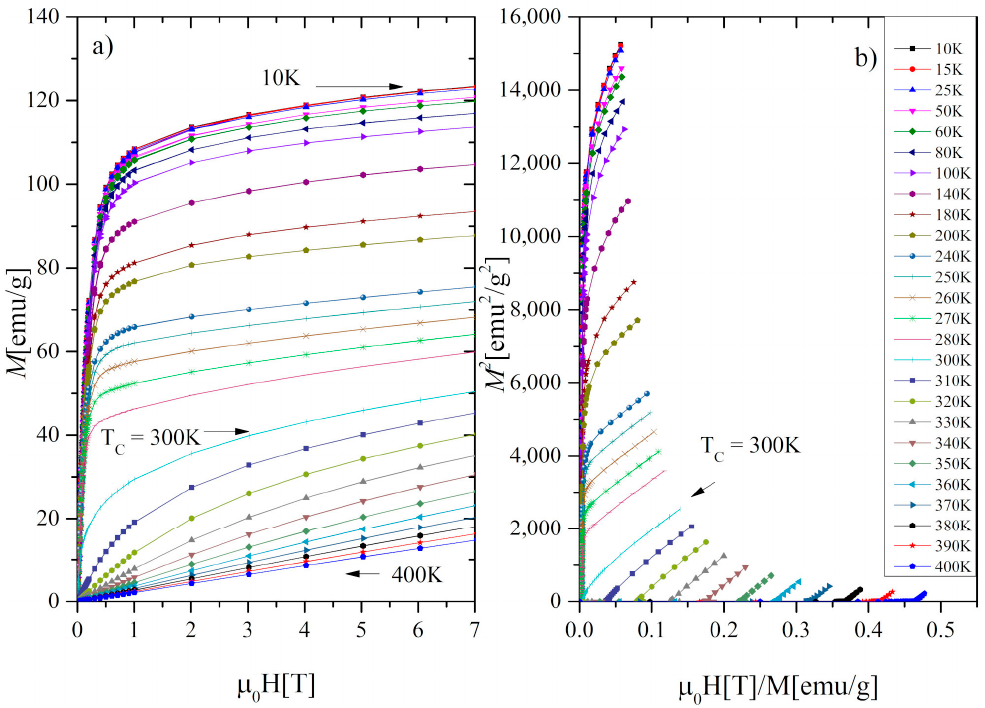
Figure 5. ( a ) Magnetic isotherms and ( b ) Arrott plots for the Gd 0.4 Tb 0.6 Co 2 .